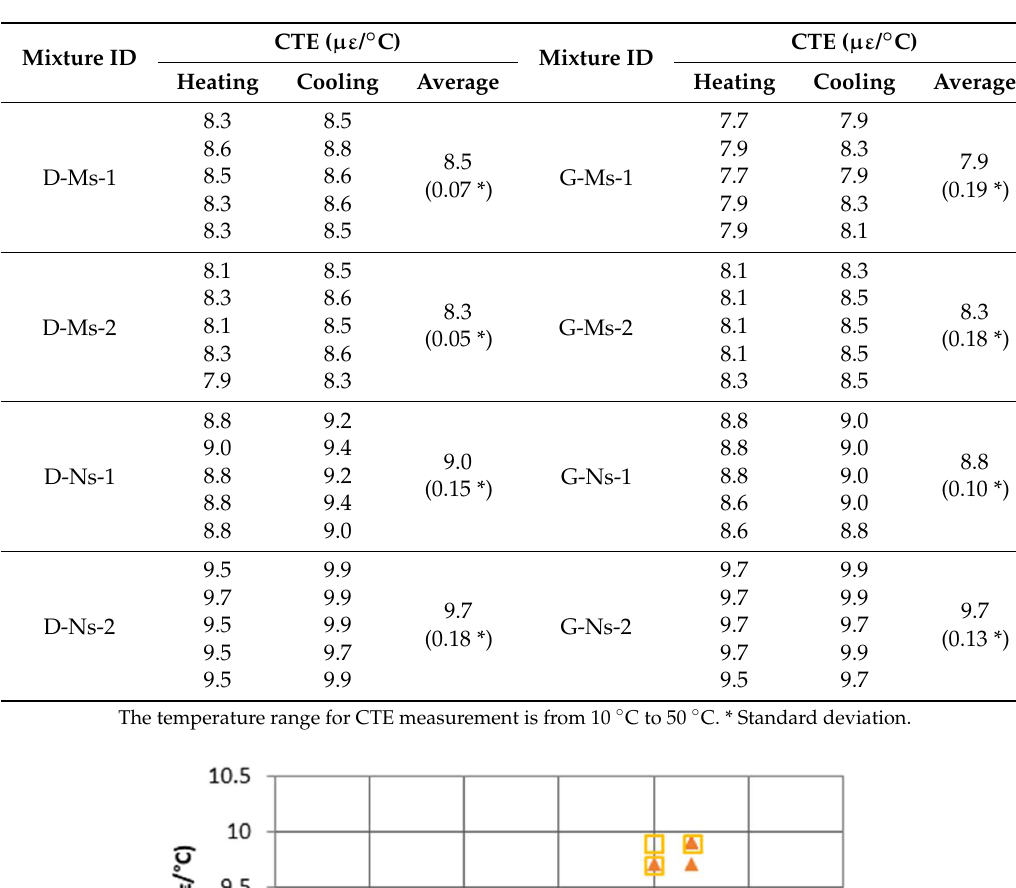
Table 3. Measured and average CTE values.